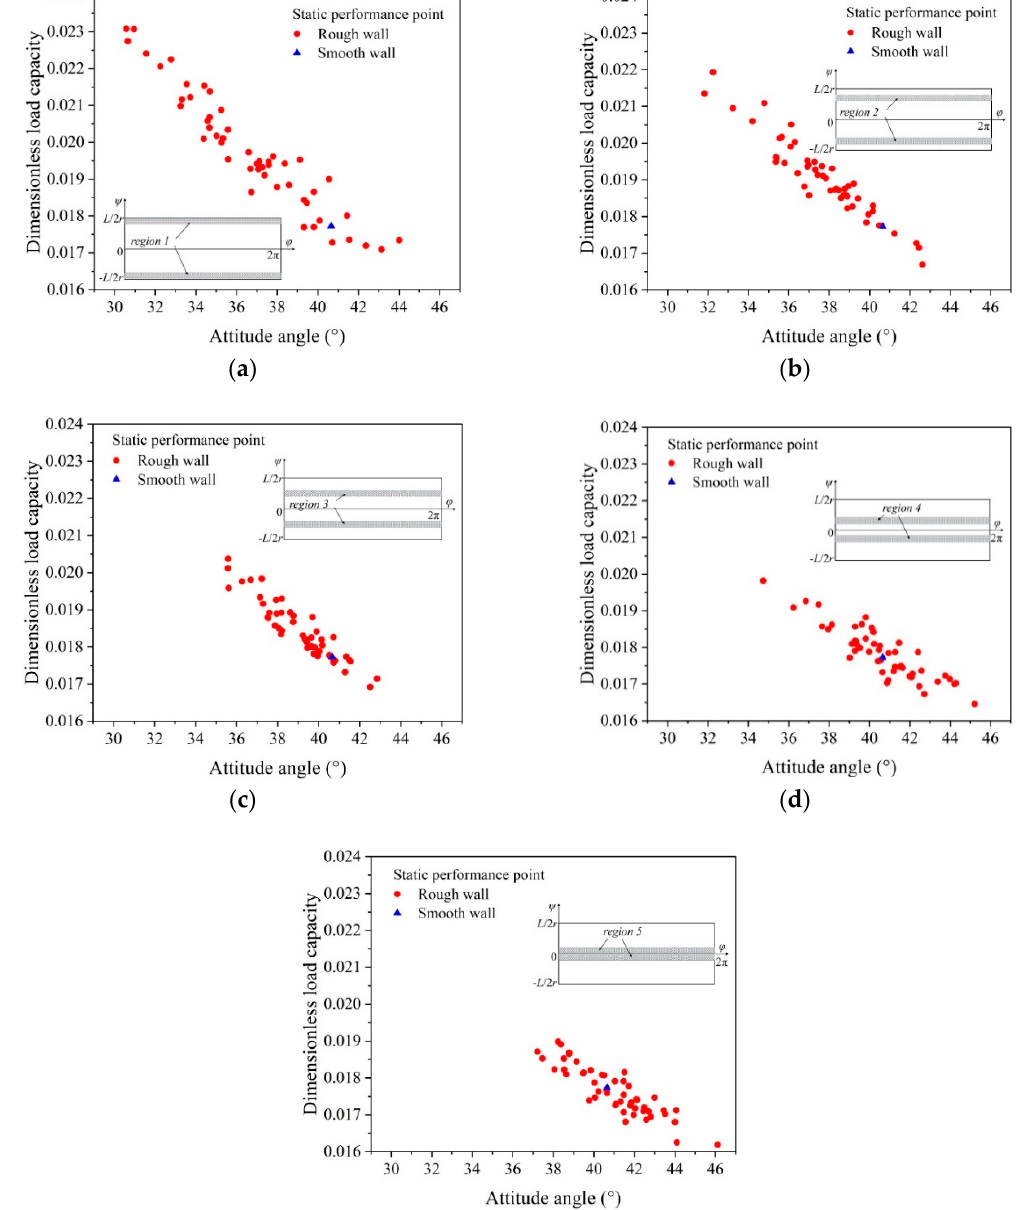
Figure 8. Static performance point distribution with wear in axial regions. ( a ) axial region 1. ( b ) axial region 2. ( c ) axial region 3. ( d ) axial region 4. ( e ) axial region 5.